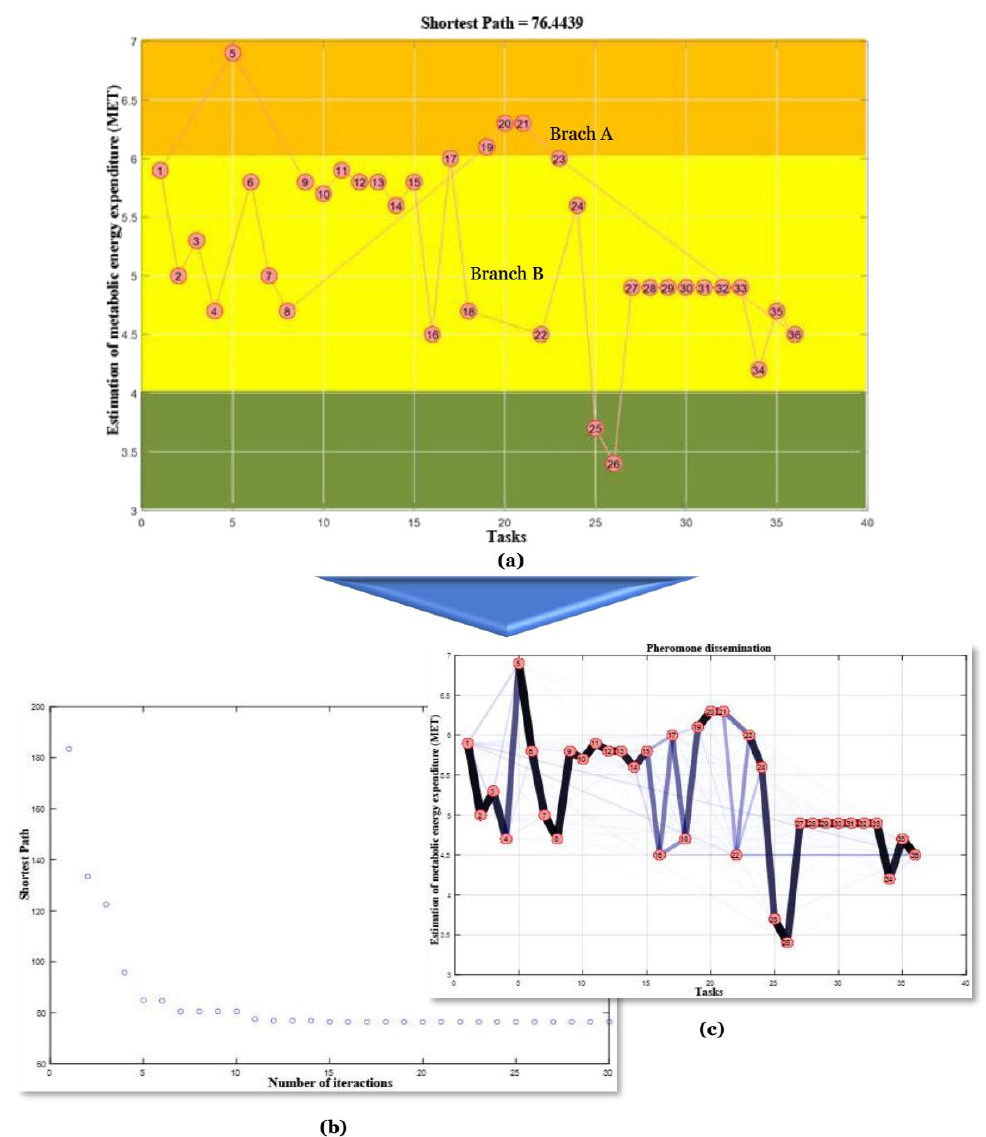
Figure 6. Graph representation of scenario 3. ( a ) Solution for optimizing the planning of production activities for the high season (during the harvest, with the various levels of metabolic energy expenditure in METs. ( b ) Evolution of the shortest path minimization process. ( c ) Dissemination of pheromones in the different paths along with the iterations.